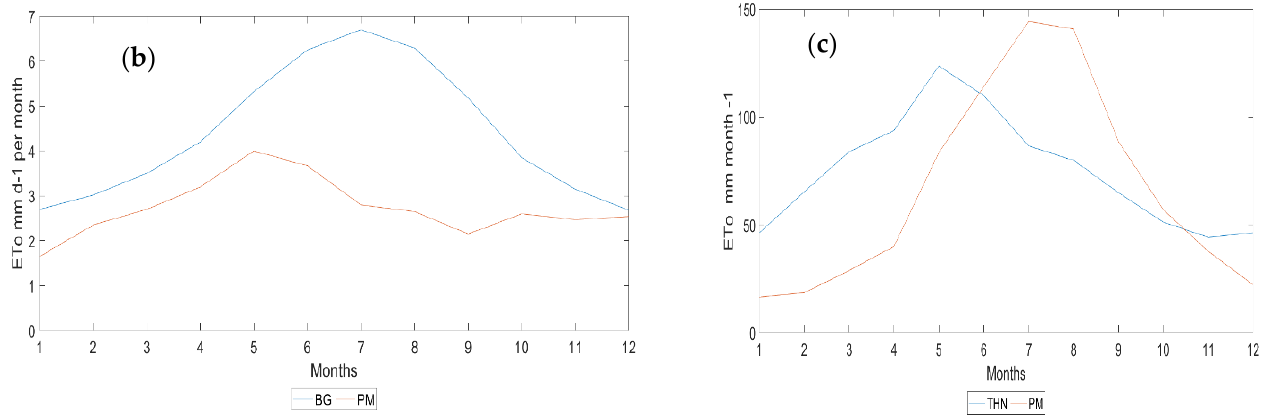
Figure 2. Comparison of PM ETo time-series data to other ETo estimation methods: ( a ) daily ETo in mm for PM, PT, BR, HS, JH, MKK, RIT, and TUR from 1 July 2019 to 14 January 2022; ( b ) average daily ETO per month for PM and BG from 1 July 2019 to 14 January 2022; ( c ) monthly ETo in mm for PM and THN from 1 July 2019 to 14 January 2022. N.B.: BG and THN are calculated based on monthly timescale, and the others were daily scale.